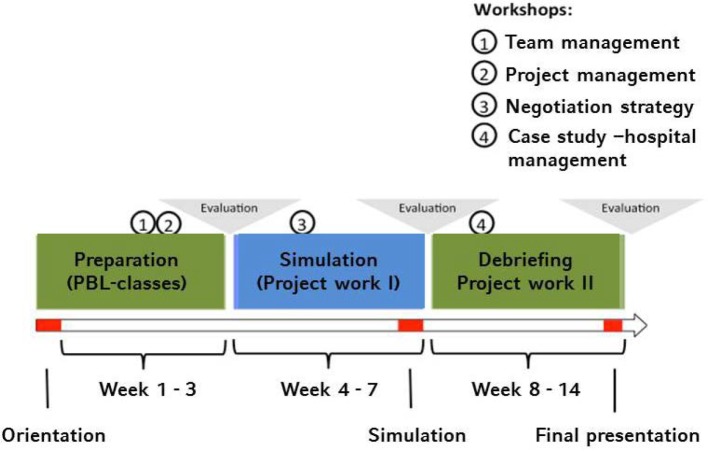
Course structure